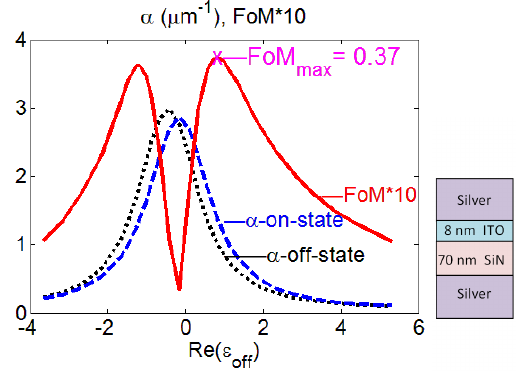
Figure 8: Influence of ITO permittivity on the absorption coeflcient and FoM of the metal-insulator-metal-waveguide-based modulator. To obtain the complex propagation constant, the dispersion equa- tion was solved for a four-layer structure, that is, 8-nm thick ITO and 70-nm thick silicon nitride insulation embedded in silver claddings, where the real part of the ITO permittivity was varied. Copyright (2012), Elsevier, from Ref. [139], with permission of the authors. ITO: